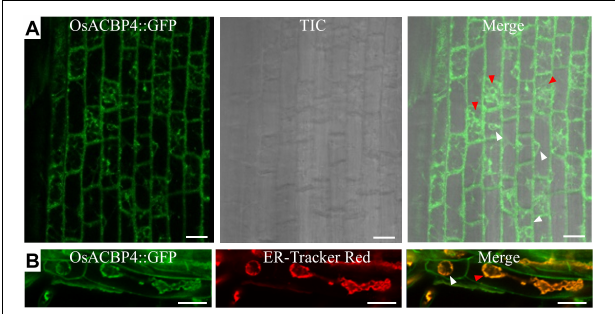
FIGURE 2 | Subcellular localization of OsACBP4:GFP in transgenic rice. (A) Root cells of 4-day-old transgenic rice seedlings were imaged by confocal laser scanning microscopy. Signals were detected at the central cisternal ER (red arrow), the perinuclear ER (white arrow) and plasma membrane or cell wall. (B) Colocalization of OsACBP4:GFP (green) with ER-Tracker Red (red) (E34250, Invitrogen) in root cells of 4-day-old transgenic rice seedlings. Signals were colocalized at the central cisternal ER (red arrows), the perinuclear ER (white arrows) and plasma membrane or cell wall. Bars = 20 µ m. ACBP, acyl-CoA-binding protein; ER, endoplasmic reticulum; Os, Oryza sativa . Representative images were shown after observation with consistent results from at least 20 cells in (A) for central cisternal ER and perinuclear ER and in (B) for cisternal ER. Representative images were shown after observation with consistent results from at least 6 cells for perinuclear ER in (B) .